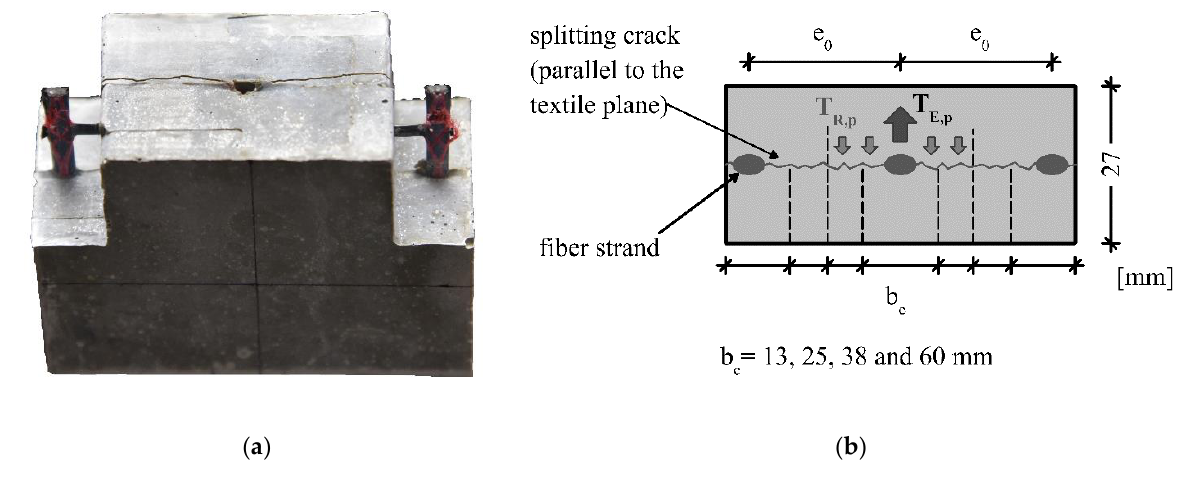
Figure 3. Splitting of a TRC specimen due to the pulling out of a single fiber strand: ( a ) cracked specimen [18]; ( b ) mechanical model to describe the acting (T E,p ) and resisting (T R,p ) forces in the TRC.